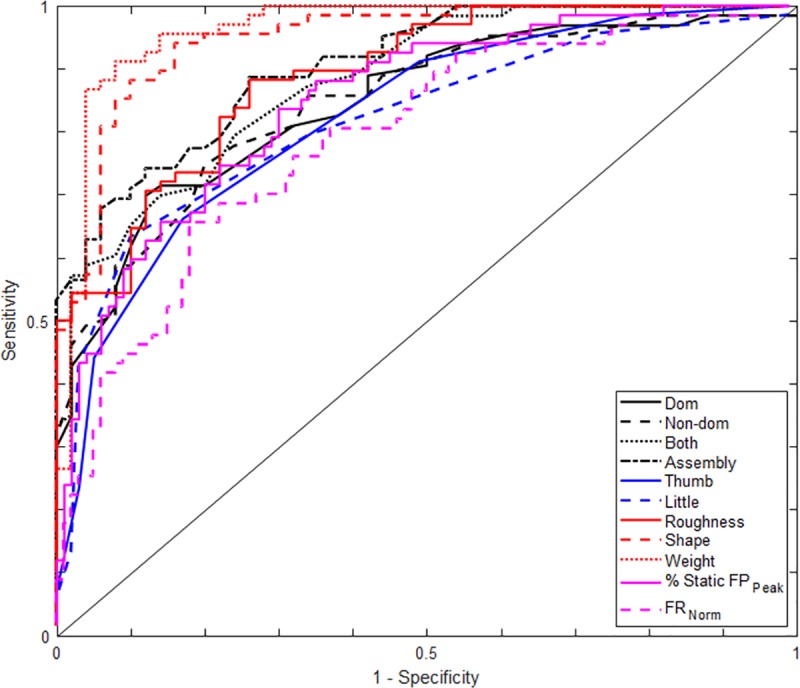
ROC curves of each hand function assessment tools.Black lines are from the Purdue Pegboard test, blue lines are from the SWM test, red lines are from the MTT and purple lines are from the PHUA test.